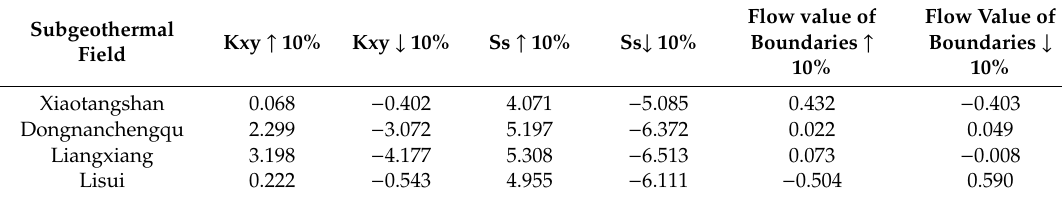
Table 8. Fitting error of thermal groundwater level in simulation